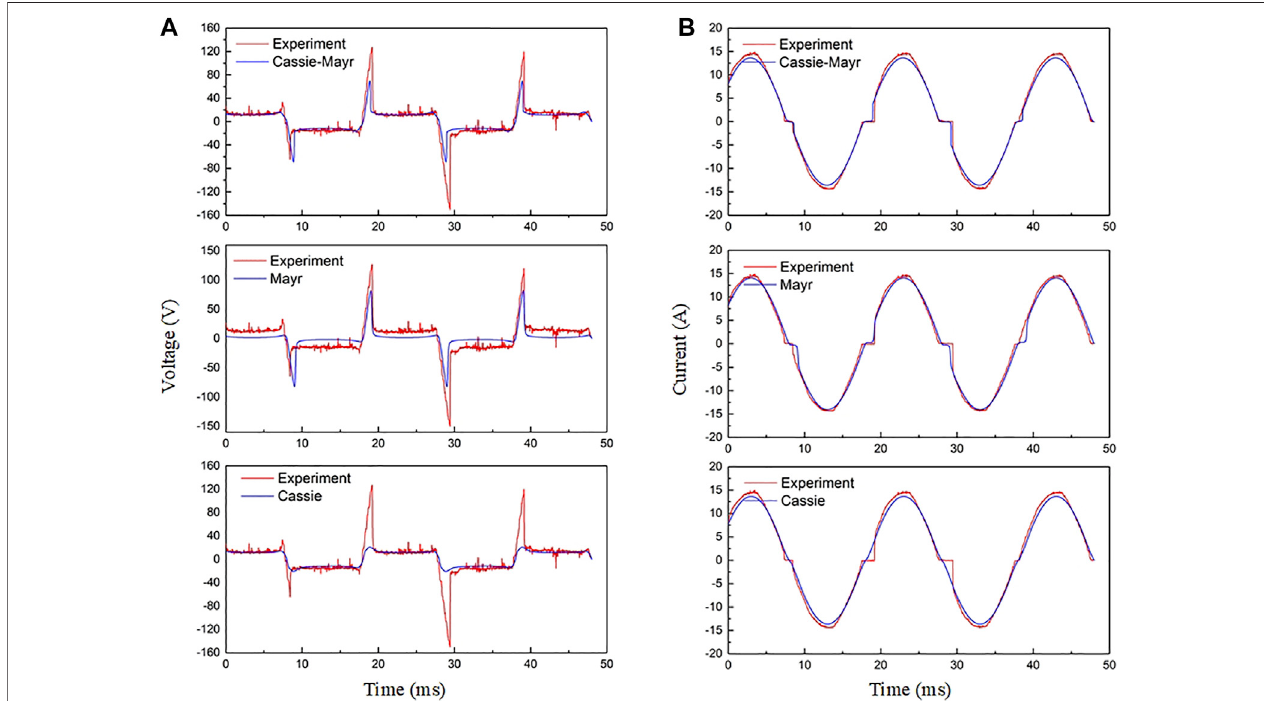
FIGURE 8 | Comparison between experiment, Cassie-Mayr, Cassie, and Mayr results of a 22 Ω resistive load. (A) Arc voltage; (B) arc current.